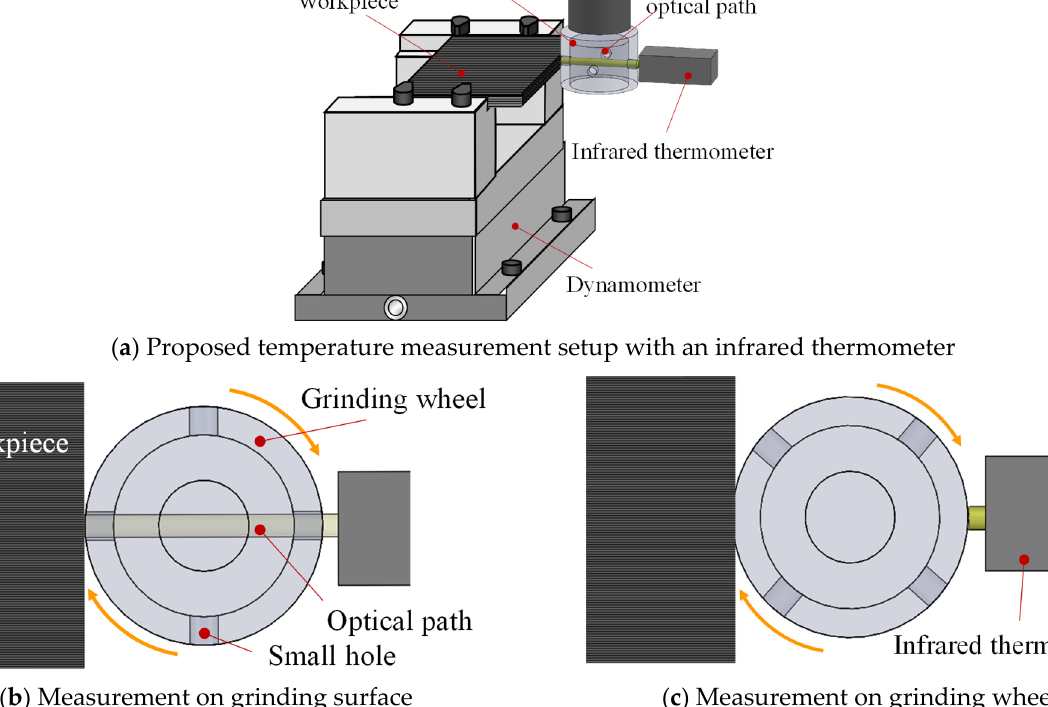
Figure 2. Measurement concept and its setup.